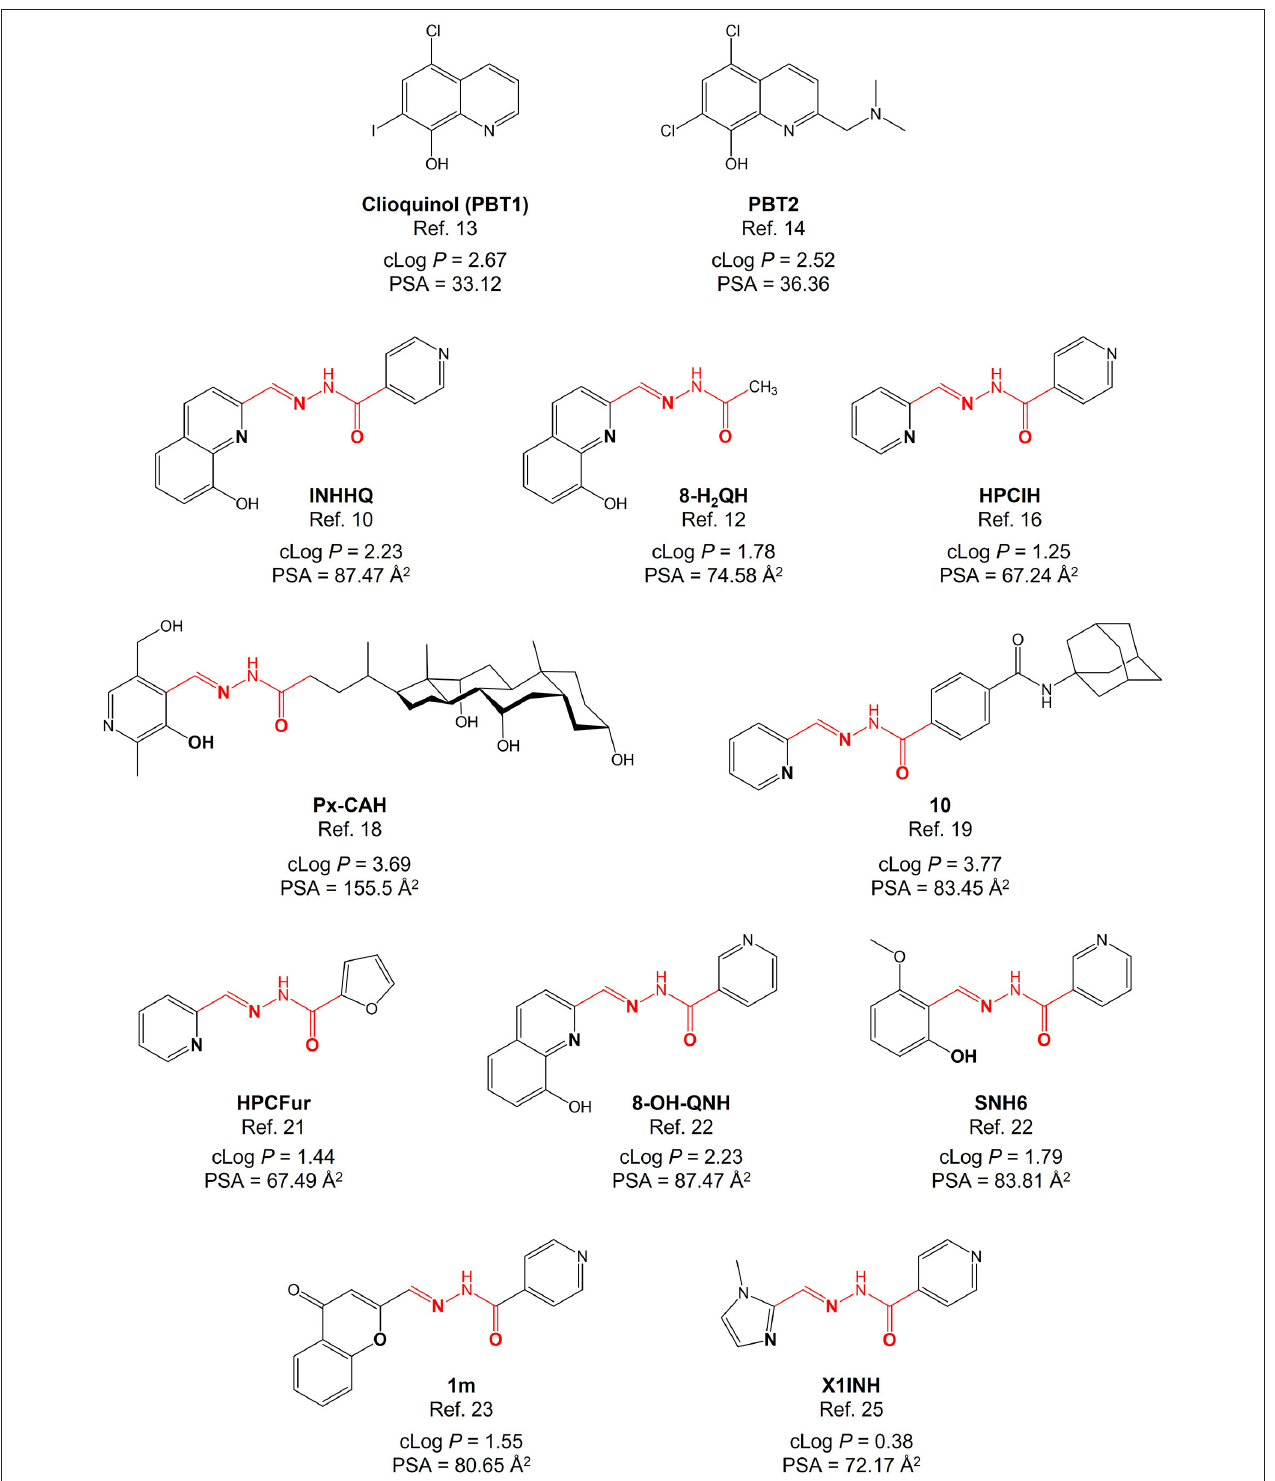
FIGURE 1 | Structures of some relevant N -acylhydrazonic metallophores mentioned in this section, in which the characteristic functional group is highlighted in red. Clioquinol and PBT2 were included for the sake of comparison. For each compound, the calculated physicochemical parameters log P and PSA are also presented. Putative donor atoms of the N -acylhydrazones are emphasized in